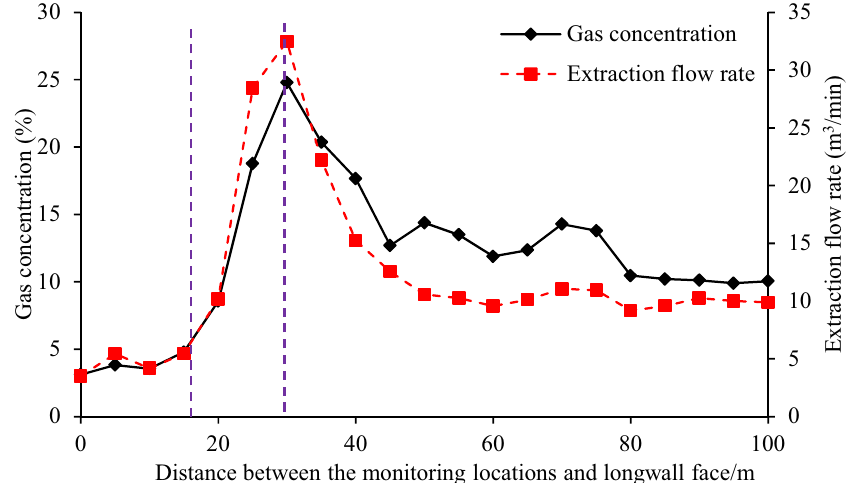
Figure 11. Gas extraction flow rate and gas concentration in the high roof roadway drainage in